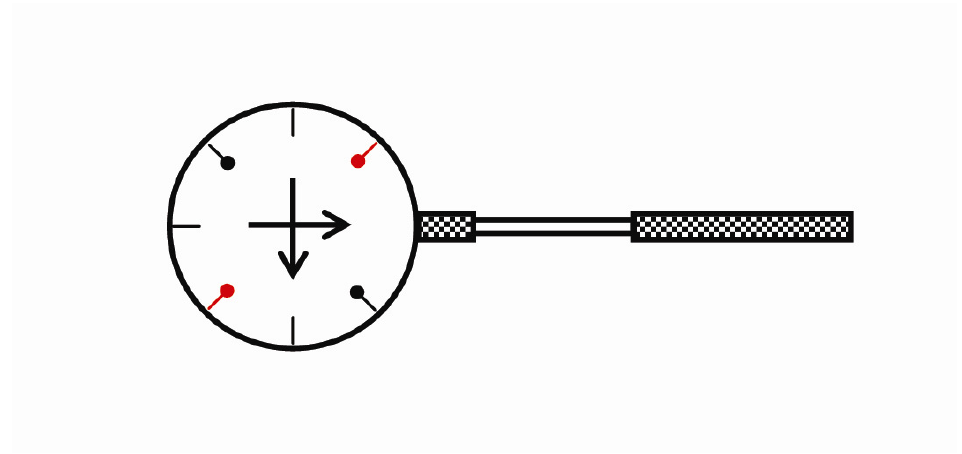
Figure 8 Apparent cross-motion of objects viewed through the lens. Moving the lens in the direction that the handle points (to the right here) makes objects viewed through the lens appear to move vertically downward. Moving the lens downward (in a direction perpendicular to the handle) causes objects to appear to move to the